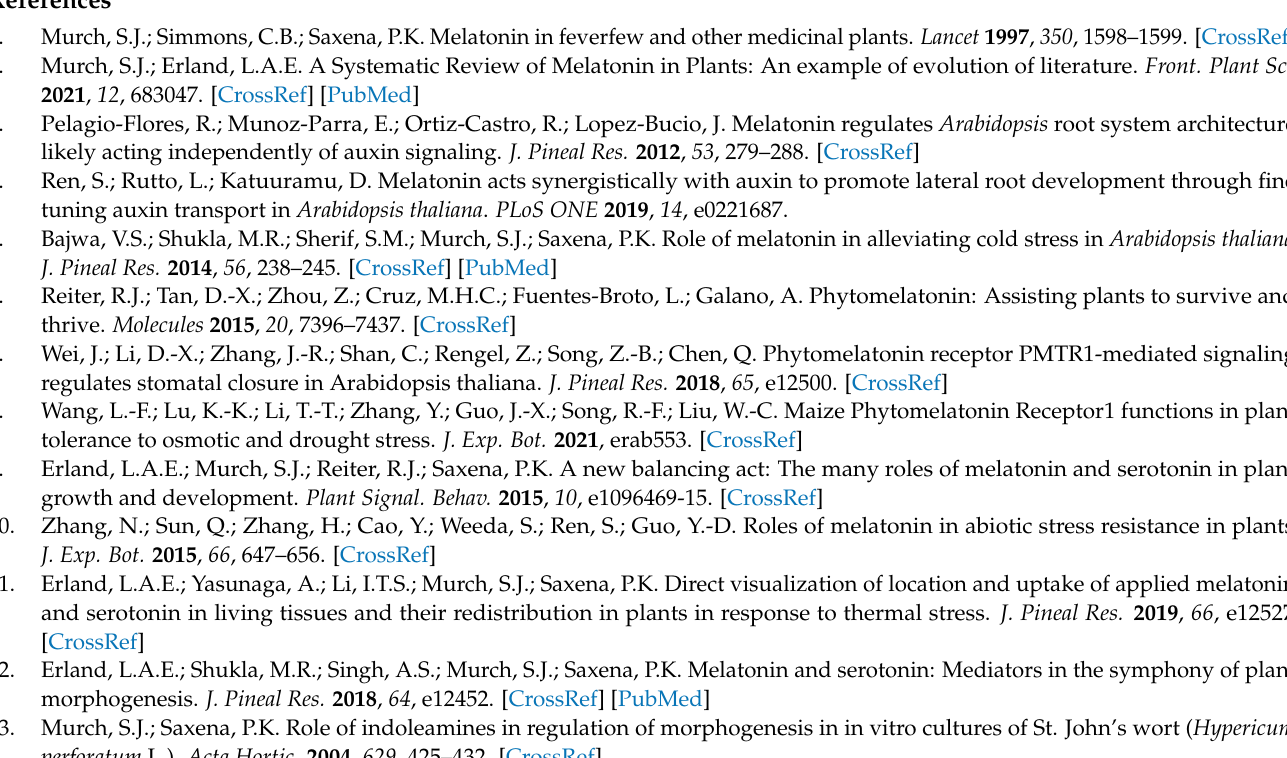
Figure S3: Gel images of GABI-Kat confirmation strategy for presence of T-DNA insertion in RBL7 gene in Arabidopsis lines used in this study. Figure S4: Gel images of GABI-Kat confirmation strategy for presence of T-DNA insertion in RBL7 gene in 10 progeny of self-crossed heterozygous Arabidopsis thaliana CS717302. Numbers 1–10 indicate individual progeny of the self-cross. Table S1: Summary of the GABI-Kat confirmation strategy and the genotype of the RBL7 gene for the Arabidopsis thaliana lines from ABRC (CS717300-307). Table S2: Summary of the GABI-Kat confirmation strategy and the genotype of the RBL7 gene for 10 progeny of self-crossed heterozygous Arabidopsis thaliana CS717302 Numbers 1–10 indicate individual progeny of the